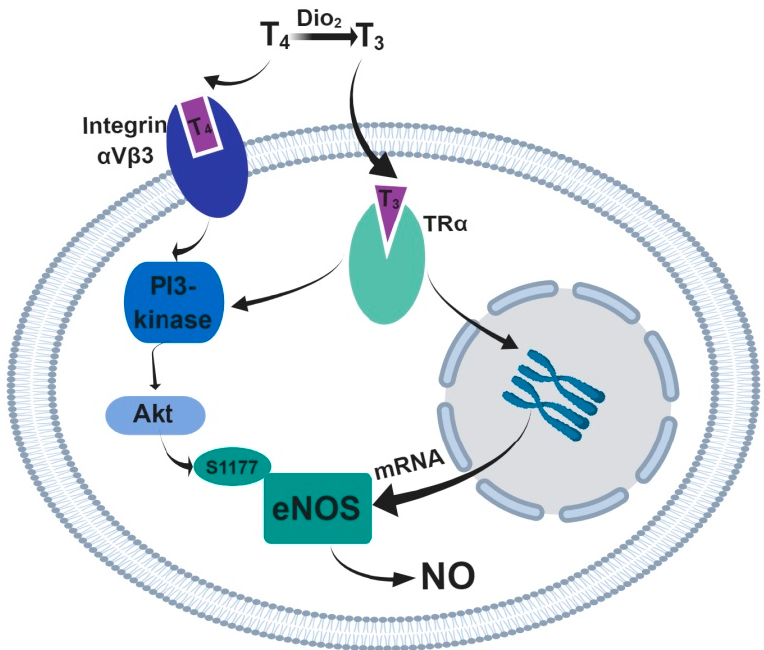
Figure 1. The effects of thyroid hormones on the activity and expression level of eNOS in vascular endothelial cells. Thyroxin (T 4 ) is converted to its active form triiodothyronine (T 3 ) by deiodinase 2 (Dio 2 ). A rapid non-genomic action of thyroid hormones can occur upon binding T 3 to the TR α and/or T 4 to integrin receptors, which both can activate the PI3/Akt-kinase signaling pathway, causing phosphorylation at the serine-1177 site and activation of eNOS. The long-term genomic effects of thyroid hormones occur upon binding of T 3 to TR α receptors, which triggers expression of eNOS